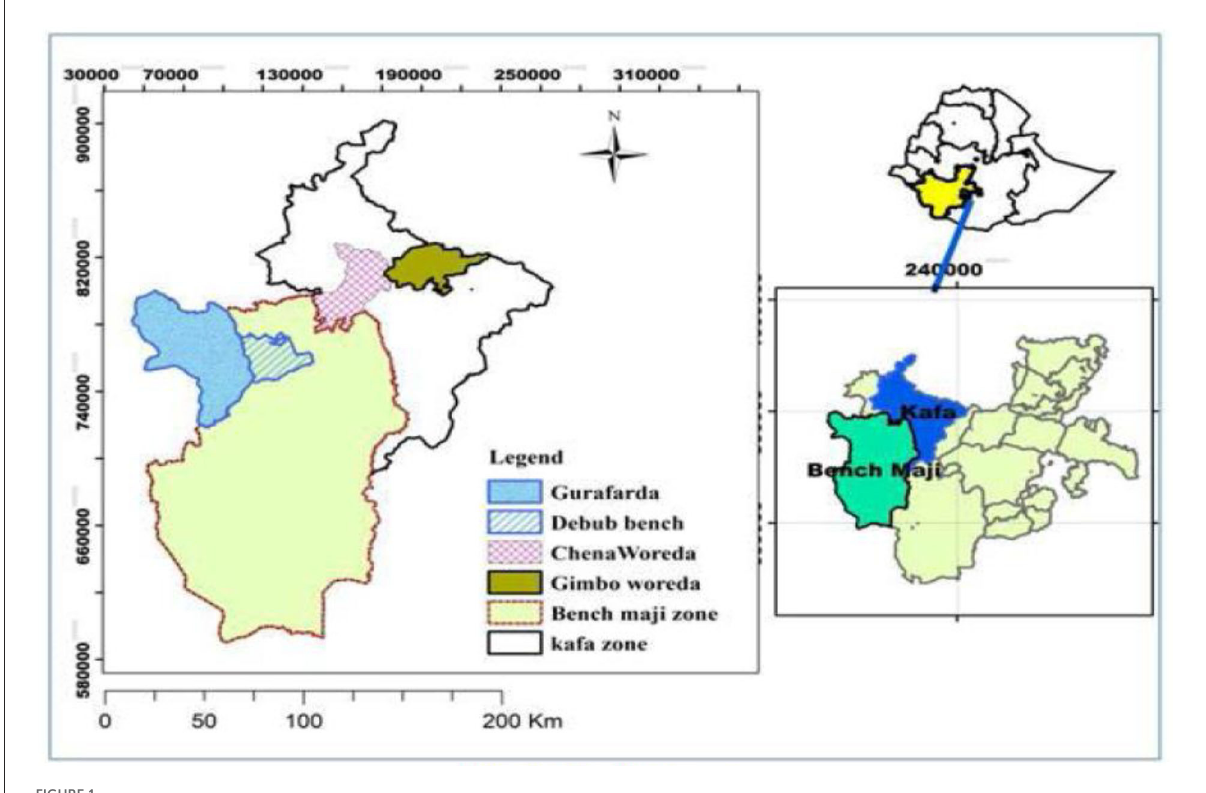
FIGURE1 Map of study area.